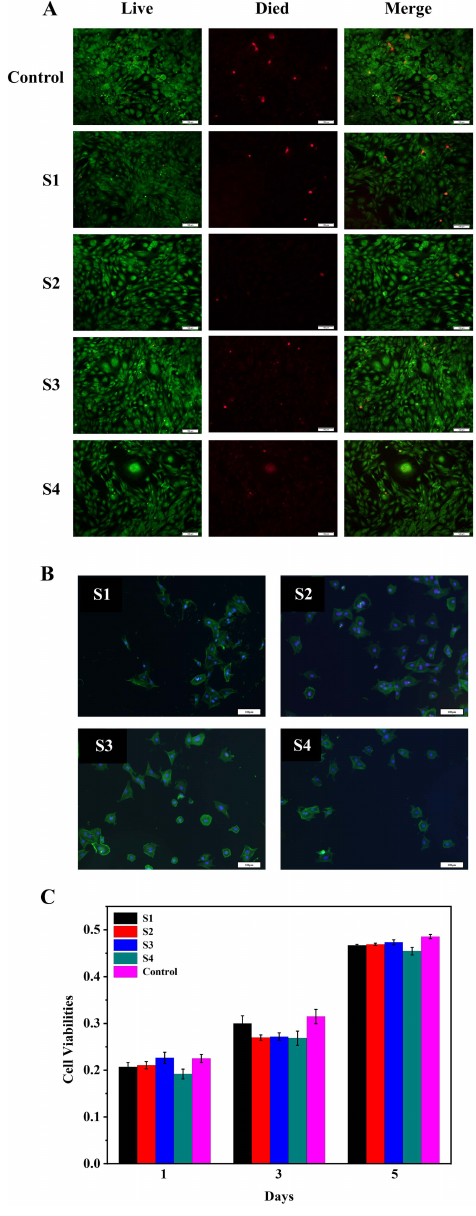
Figure 8. ( A ): Live/dead staining of the BMSCs that were cultured for 5 days on the S1–S4, respec- tively. ( B ): CLSM micrographs of the BMSCs adhesive on S1–S4 for 3 days. ( C ): Cell viabilities of the BMSCs that were cultured on the S1–S4 for 1, 3, and 5 days,